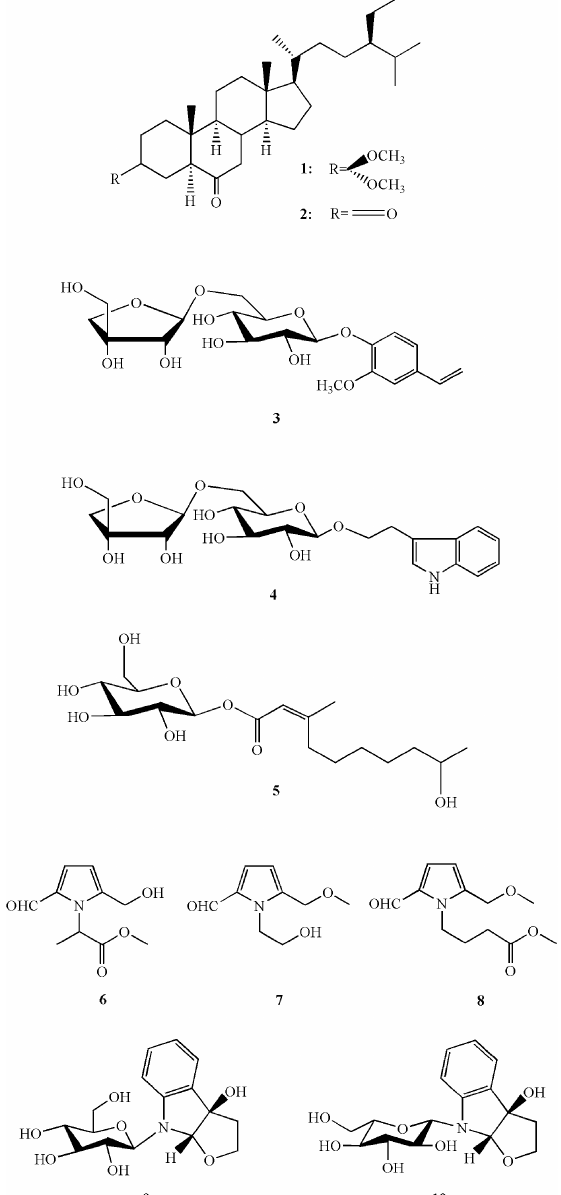
Figure 2. Chemical structures of compounds ( 1 – 10 ) isolated from the swollen culm of Z. latifolia .